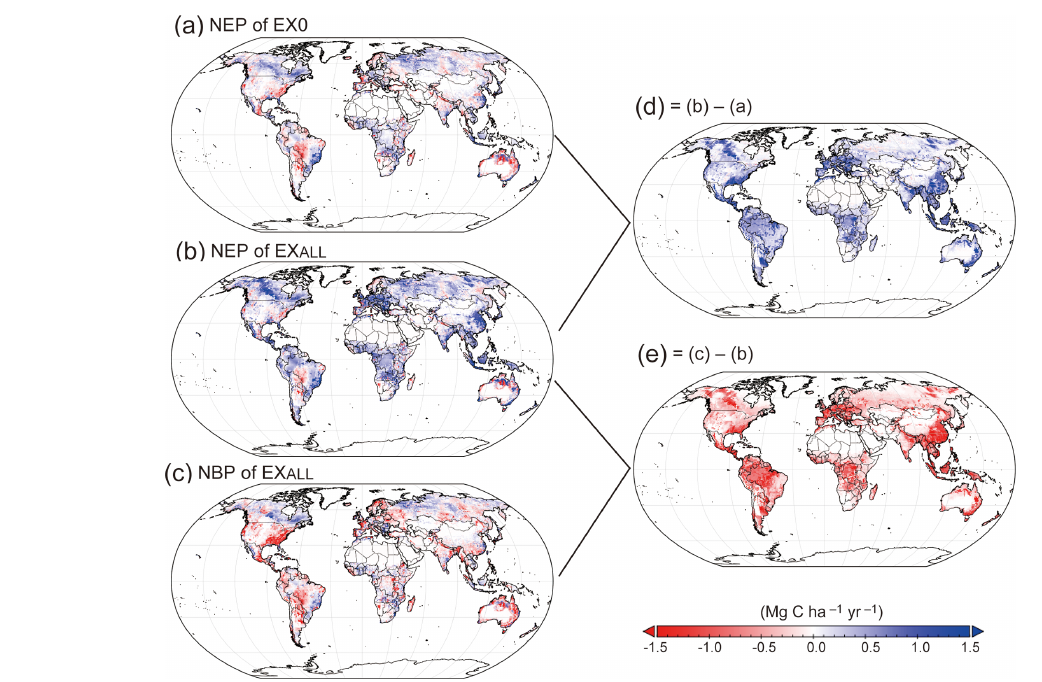
Figure 3. Global distribution of simulated terrestrial carbon budget in the 2000s. (a) NEP in EX0, (b) NEP in EX ALL , (c) NBP in EX ALL , (d) difference between panels (b) and (a) showing the apparent effects of MCFs on NEP, and (e) difference between panels (c) and (b) showing the apparent effects of MCFs on